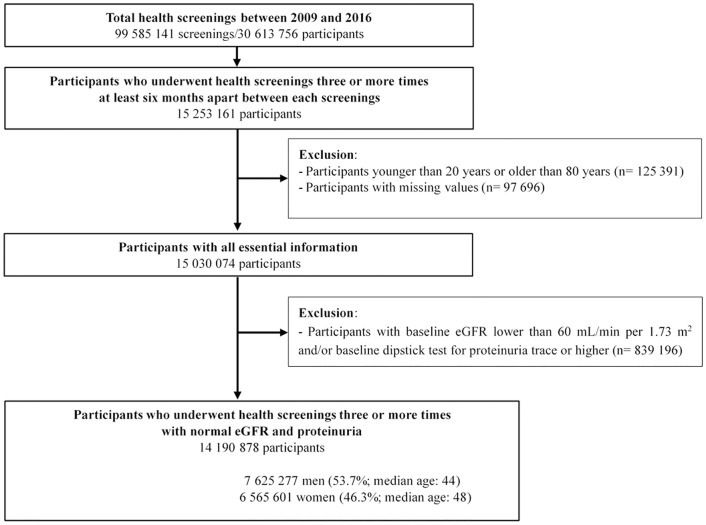
Selection of study participants.